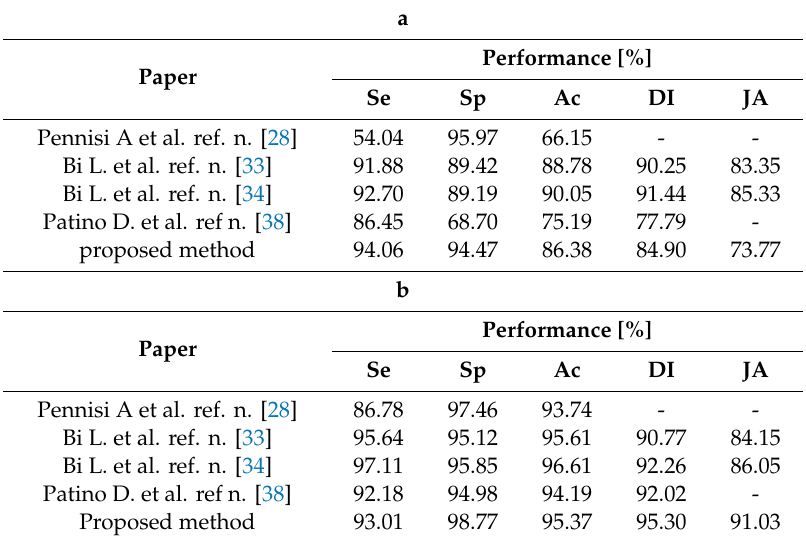
Table 2. Performance comparison for melanoma ( a ) and no-melanoma ( b ) PH 2 database